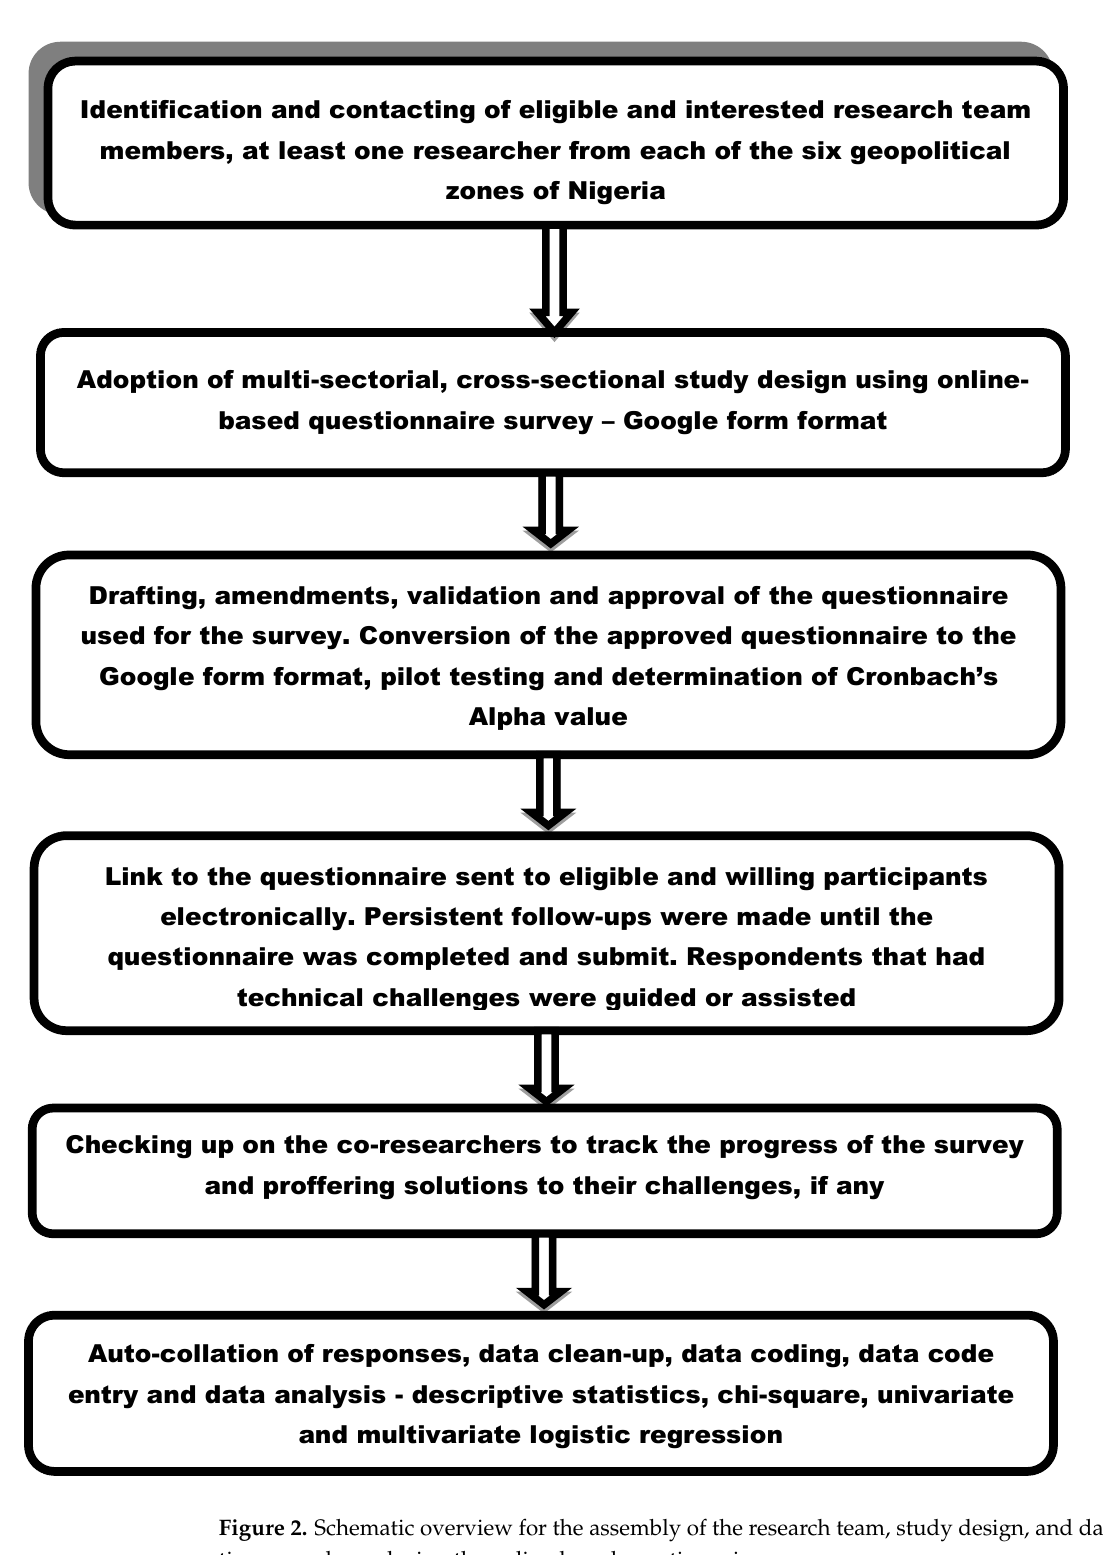
Figure 2. Schematic overview for the assembly of the research team, study design, and data acquisi- tion procedures during the online-based questionnaire survey.